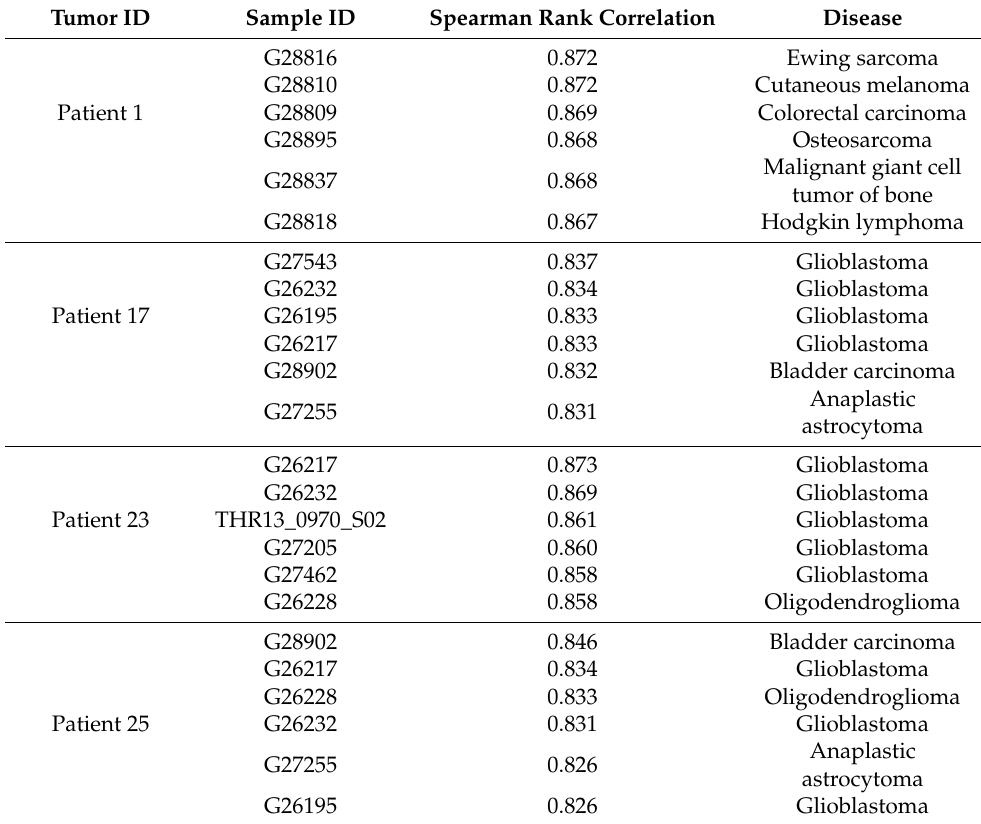
Table 2. Spearman rank correlation values of the top six highest correlated cell lines for each of the patients described in Figure